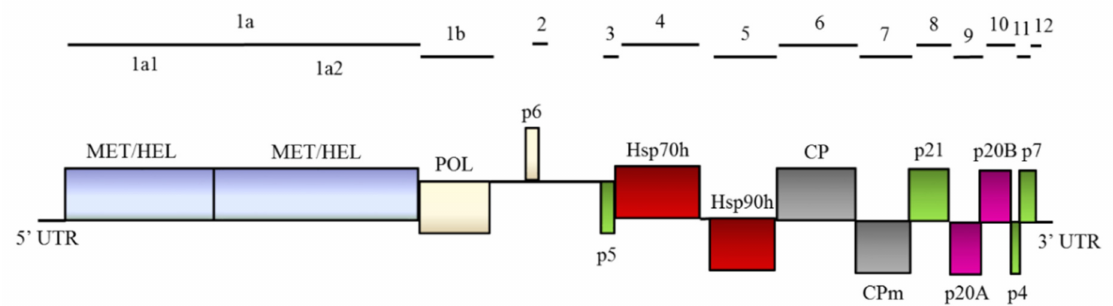
Figure 3. Schematic diagram of the GLRaV-3 genome to scale. Lines above the genome map indicate the positions of the ORFs and their corresponding numbers. In the genome map, boxes indicate positions of genes, with gene products and domains indicated. UTR, untranslated region; MET, methyltransferase; HEL, helicase; POL, RNA dependent RNA polymerase; Hsp70h, heat shock protein 70 homolog; Hsp90h, heat shock protein 90 homolog; CP, coat protein; CPm, minor coat protein.